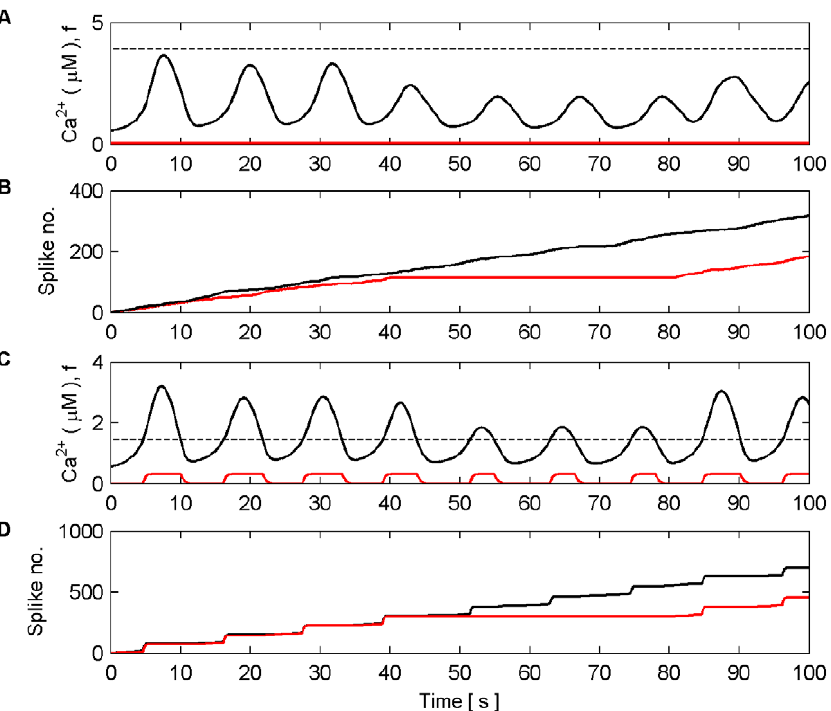
Figure 12. Example of total Ca 2 + oscillations and neural coordination with different Ca 2 + threshold levels. (A) Ca 2 + threshold (dashed line) set at 3.94 m M. (B) Neural activity of N1 (black) and N2 (red) plotted as number of spikes against time with the Ca 2 + threshold set at 3.94 m M. (C) Ca 2 + threshold set at 1.44 m M. (D) Same as (B) except that the Ca 2 + threshold is 1.44 m M. The input stimuli to the synapses for both simulations are set at 7 Hz. When the threshold is too high (A) there is no crossing of the threshold by the total level of Ca 2 + . Since there is no astrocytic global release of glutamate, f is not activated and there is no coordinating bursting of the neurons (B). In contrast, where the threshold is crossed (C) and (D), f is activated and NMDA SICs are induced (not shown) thus producing coordinated activity of N1 and N2. Note that in both cases there is a reduction in total Ca 2 + : N2 produces no firing activity because the N2 synapse receives no stimulus between 40 s and 80 s.